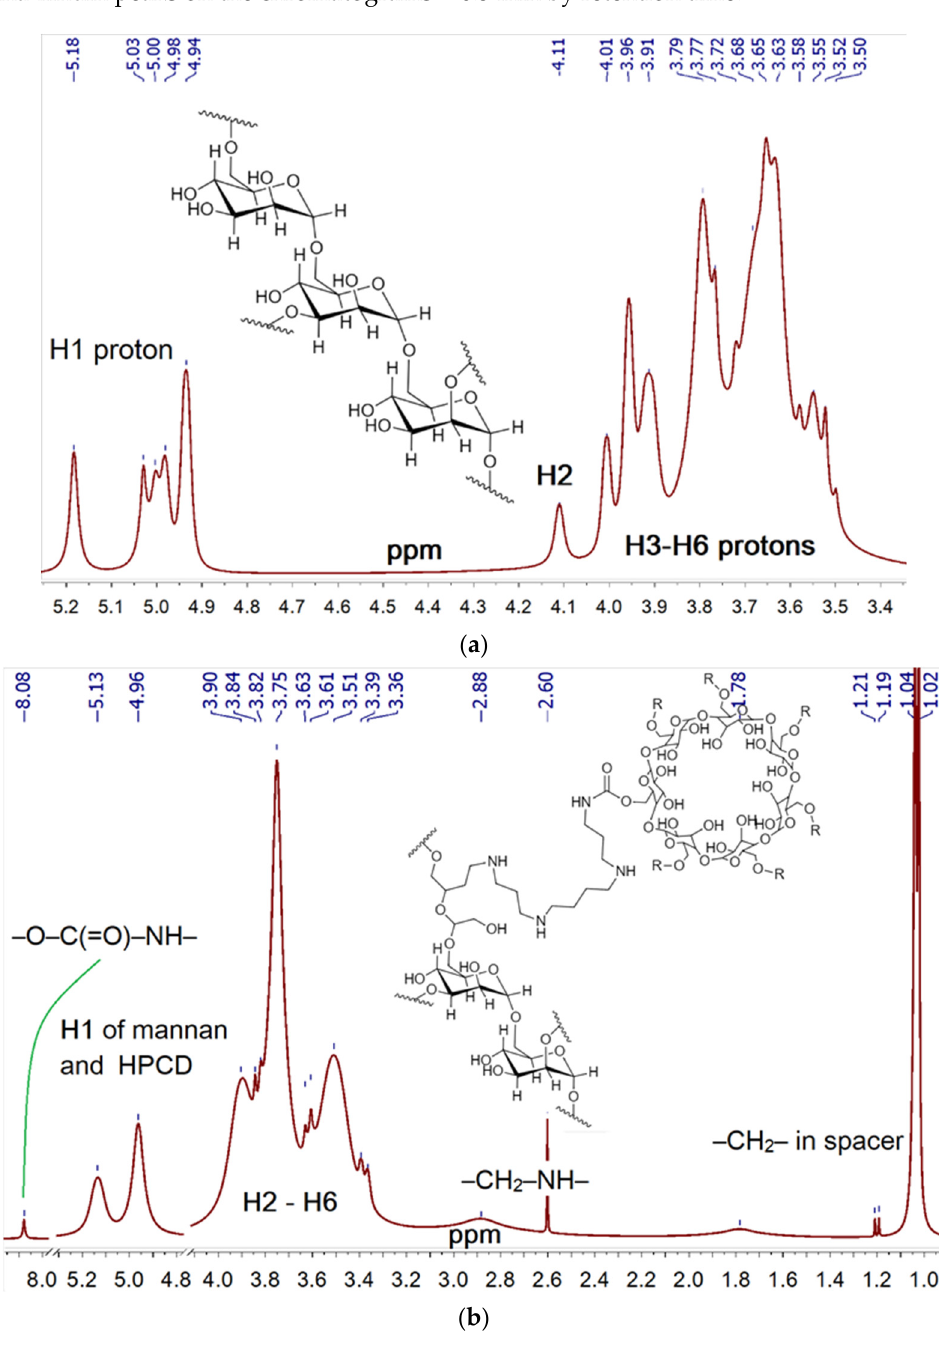
Figure 2. Fourier transform infrared spectra of mannan, amCD, HPCD, mannan-amCD and man- nan-spermine-HPCD. T = 22 °C.